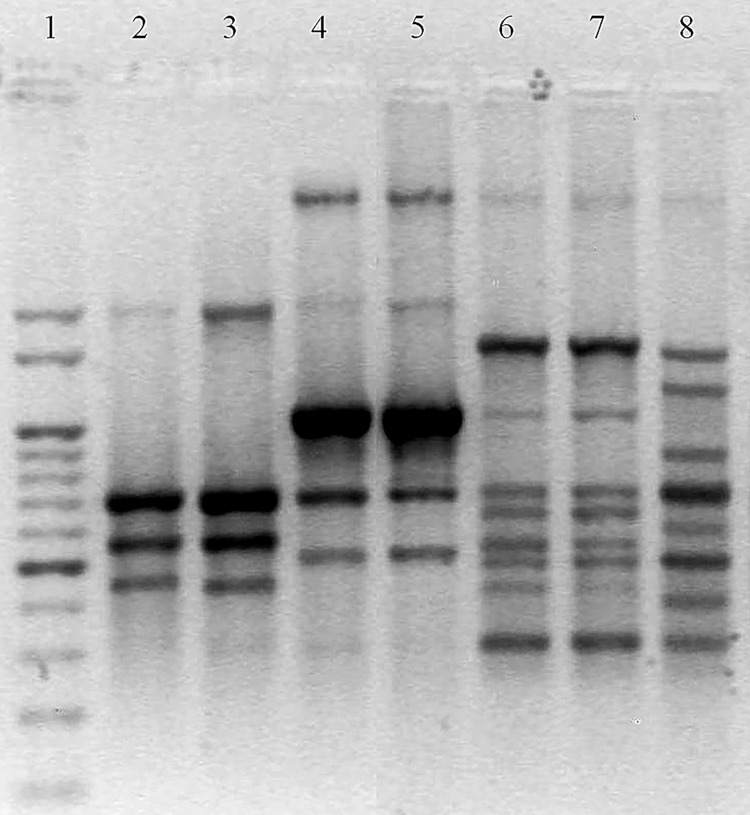
RAPD-PCR banding patterns obtained for the 33 P. aeruginosa isolates.Lane 1, DNA Ladder; lanes 2–3, milk isolates (isolates 1 and 6, G1 genotype); lanes 4–5, environmental isolates (isolates 8 and 9, G2 genotype); lanes 6–7, environmental isolates (isolates 10 and 24, G3 genotype); lane 8, the human clinical strain P. aeruginosa PAO1 has been included as a reference. The photograph of the ethidium bromide-stained gel is displayed here as a reverse picture.